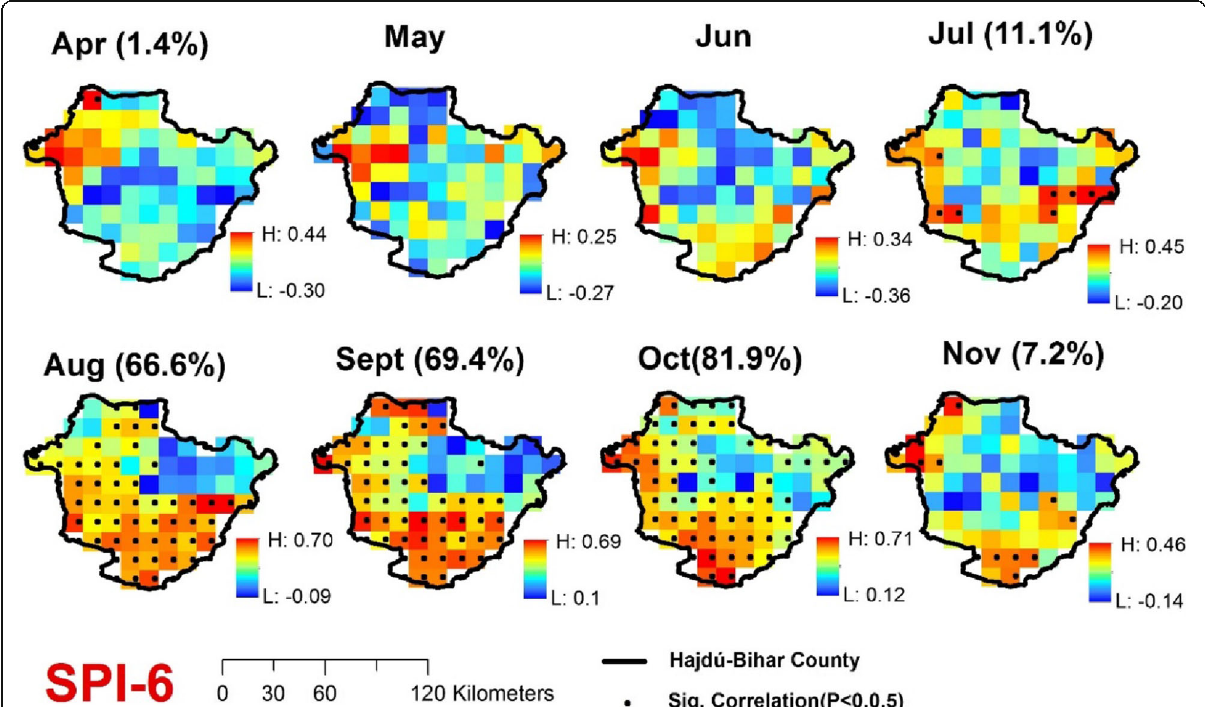
Fig. 8 Spatial-temporal correlation between monthly SPI-6-time scale and NDVI during the period of 1981 to 2010, the dots indicate to a statistically significant correlation at 95% confidence level ( P <